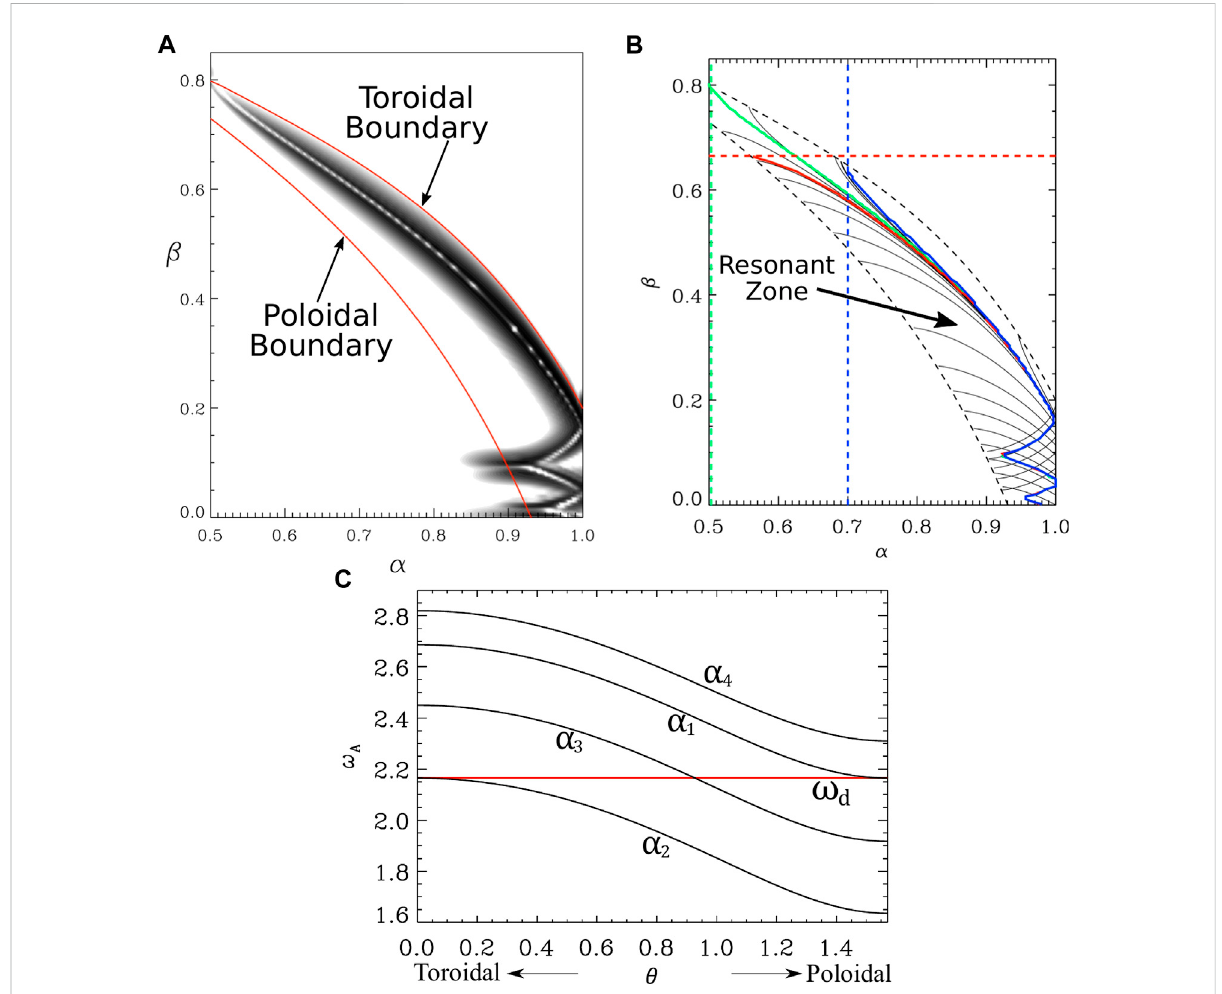
FIGURE 3 Reproduction of Figure 7 from Wright and Elsden (2016). (A) Shaded surface of the total energy density in the equatorial ( α , β ) plane from a normal mode simulation. Red lines are the poloidal and toroidal Resonant Zone boundaries. (B) Resonance map with solid black lines representing solutions satisfying the Alfvén resonance condition. Red, blue and green solid lines give the dominant solution paths for different boundary conditions and boundary locations (dashed colored lines) as further explained in the main text. (C) Variation of Alfvén frequency ω A with polarisation angle θ for four fi eld lines at different radial distances labelled α 1 ... α 4 . The red line gives the fast driving frequency ω d (adapted from Figure 6 of Wright and Elsden